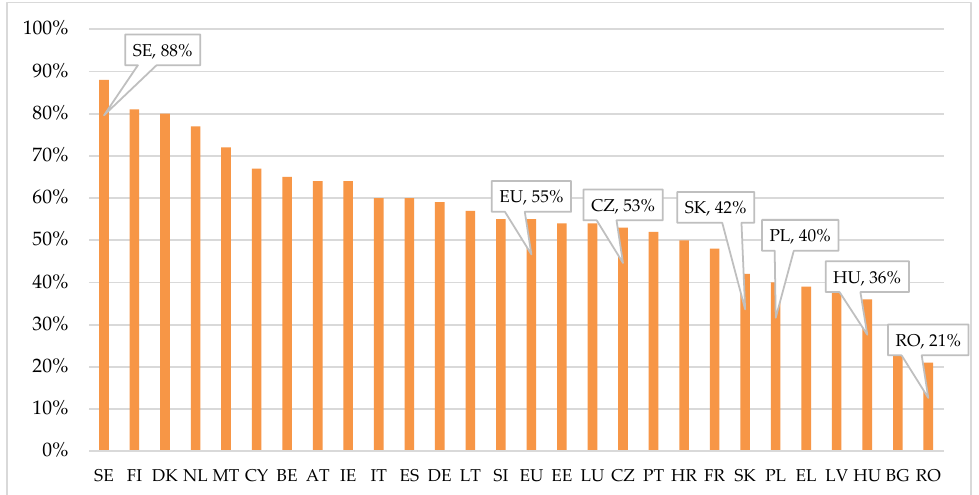
Figure 6. SMEs with at least a basic level of digital intensity (2021). Source: Authors’ compilation according to [71] and cumulative data.